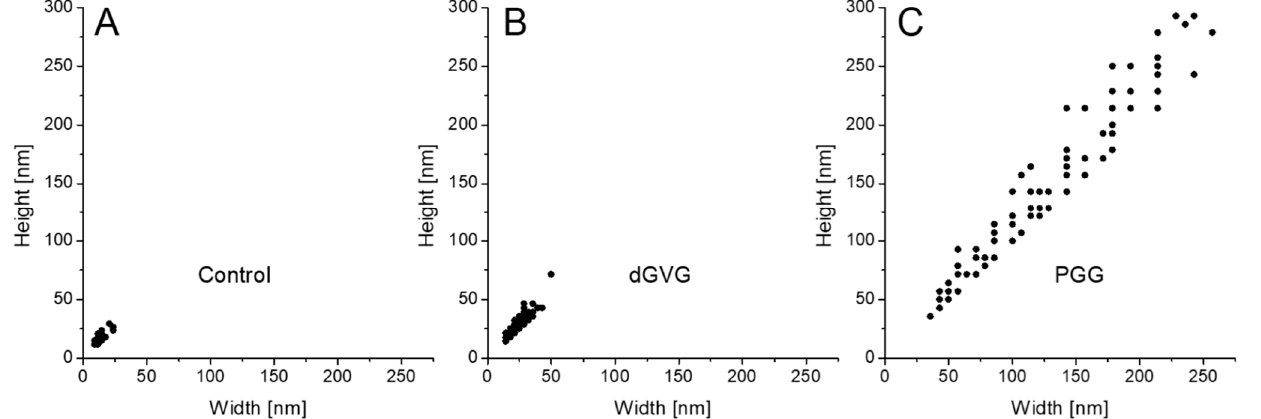
Figure 8. The size distribution of purified S. aureus membrane vesicles. MVs were released by bacteria cultivated in the absence of the tannins of control ( A ), 40 μ M dGVG ( B ), and 40 μ M PGG ( C ). n = 100 for each condition.